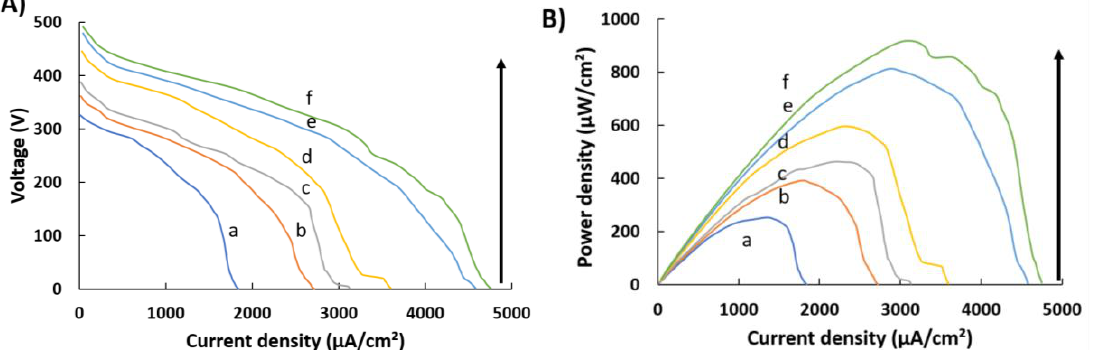
Figure 4. ( A ) Current density-voltage and ( B ) power density-current characteristics for human plasma glucose (a) 2.78, (b) 4, (c) 5, (d) 7, (e) 10, and (f) 11.11 mM) in air, pH = 7.4.